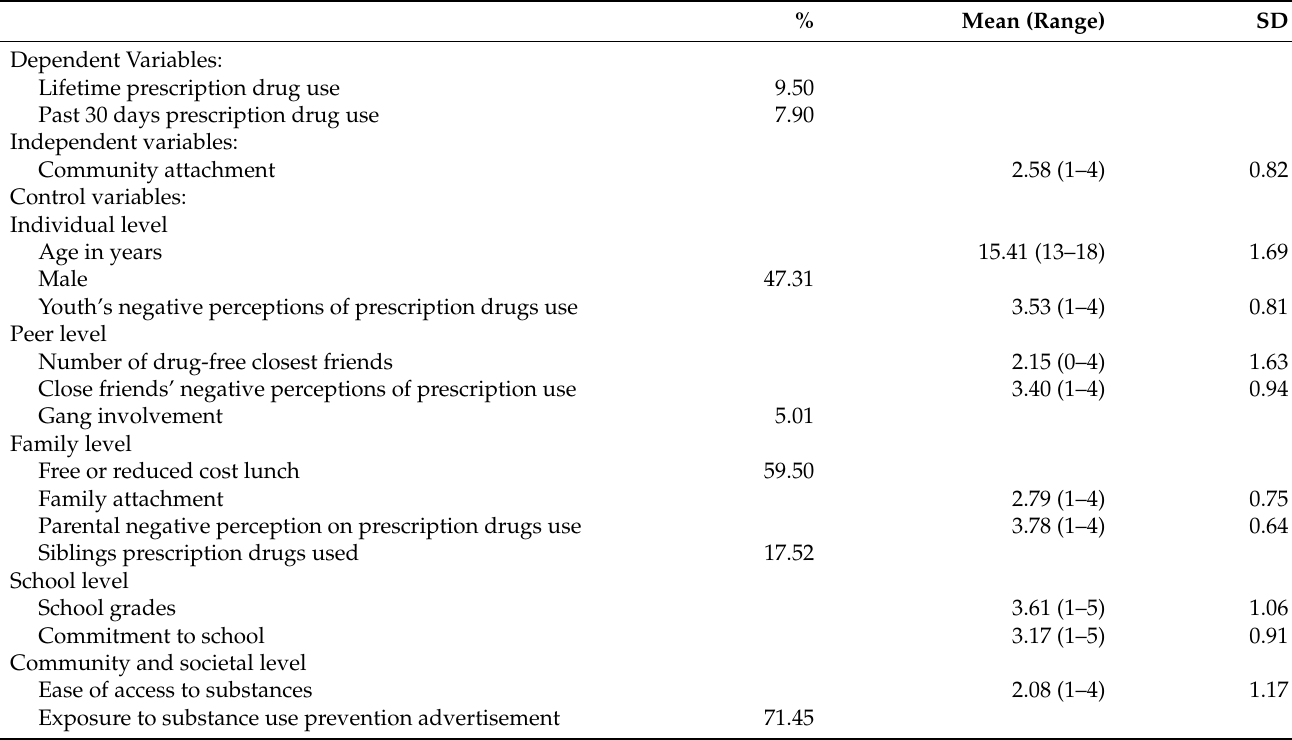
Table 1. Sample descriptive statistics (N = 2494).